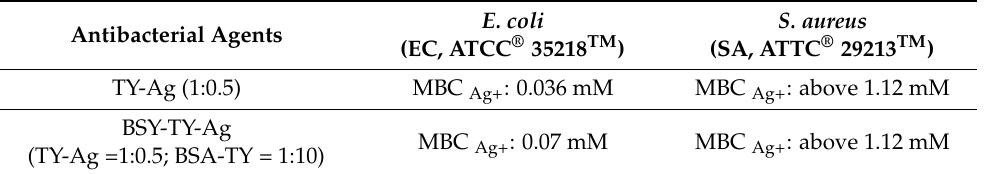
Table 3. Minimum Bactericidal Concentration (MBC) of silver complexes with TY or with BSA-TY in different molar ratios for two reference strains: E. coli and S. aureus.